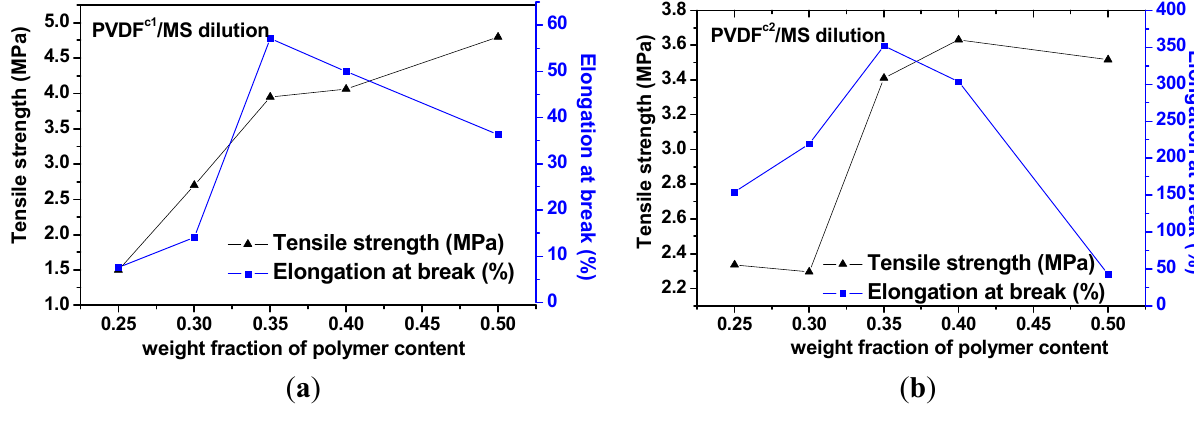
Figure 9. Tensile strength and elongation at break for membranes derived from PVDF copolymer/MS dilutions with various polymer contents that were quenched, from the melt to the ice water bath. ( a ) PVDF c1 /MS diluted system; ( b ) PVDF c2 /MS diluted